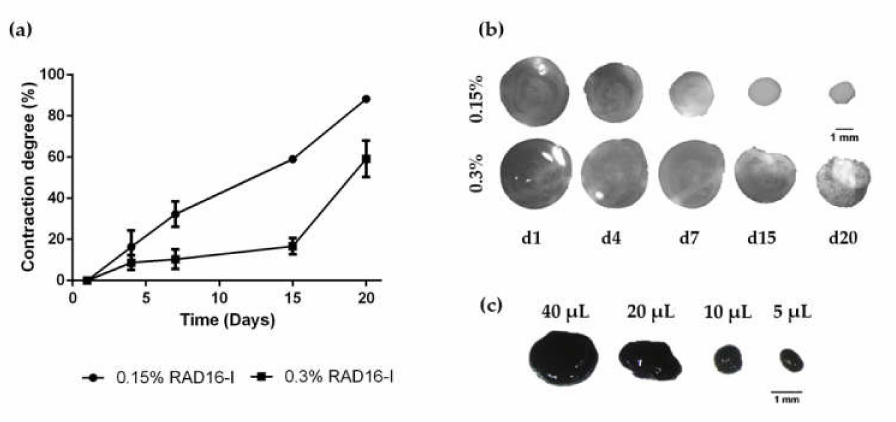
Figure 2. Matrix contraction of HFDPC in RAD16-I sca ff olds. ( a ) Matrix contraction degree in soft (0.15%) and sti ff (0.3%) hydrogels; ( b ) Macroscopic view of 0.15% and 0.3% peptide concentration 3D constructs along culture time; ( c ) 0.15% RAD16-I constructs at day 7 of culture stained by MTT. Construct size can be modulated by changing the initial seeding